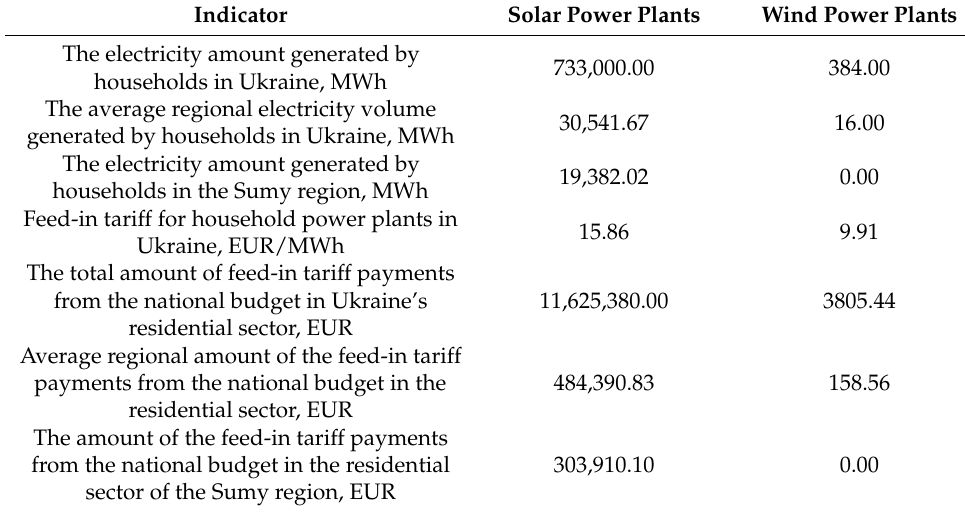
Table 5. The feed-in tariff payments from the national budget for solar and wind energy facilities in Ukraine and the Sumy region (calculated by the